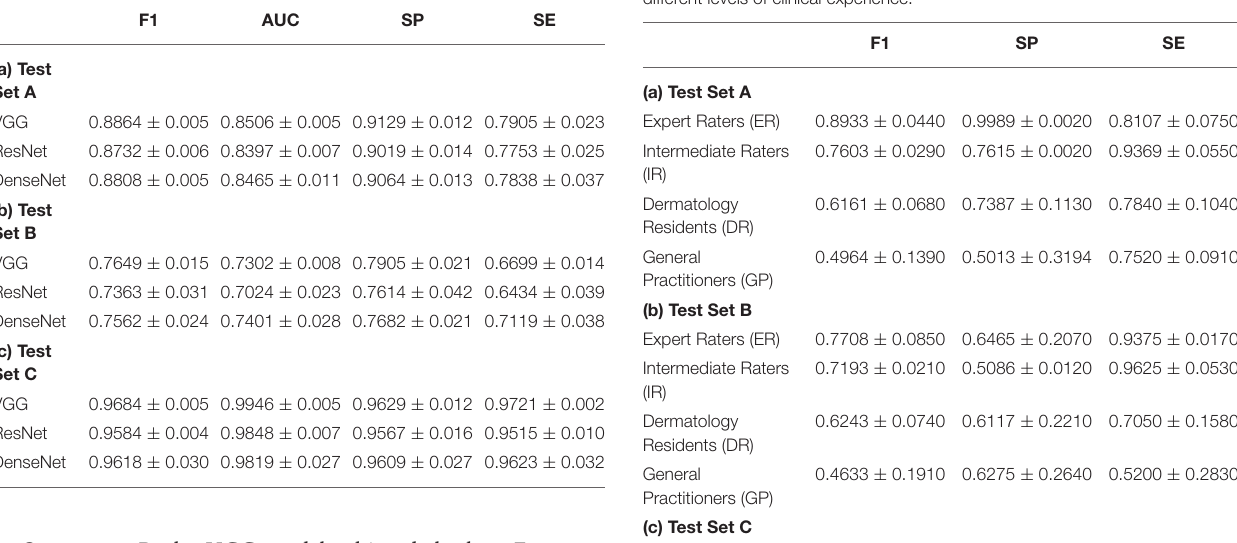
TABLE 2 | Quantitative results of CNN based vitiligo classification. TABLE 3 | Quantitative results of vitiligo classification by human raters with different levels of clinical